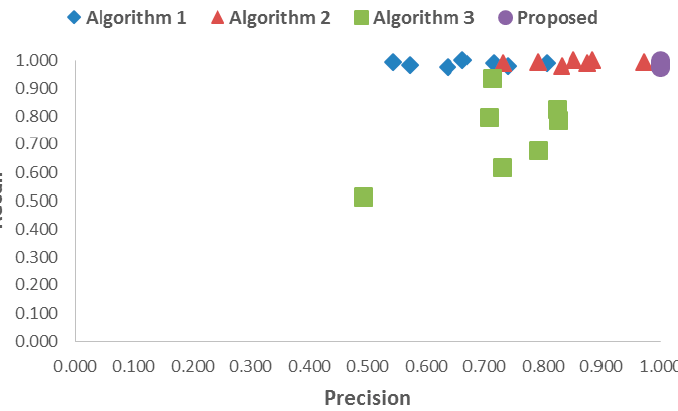
Figure 8. The data distribution of the precision-recall graph for the proposed and benchmark algorithms.